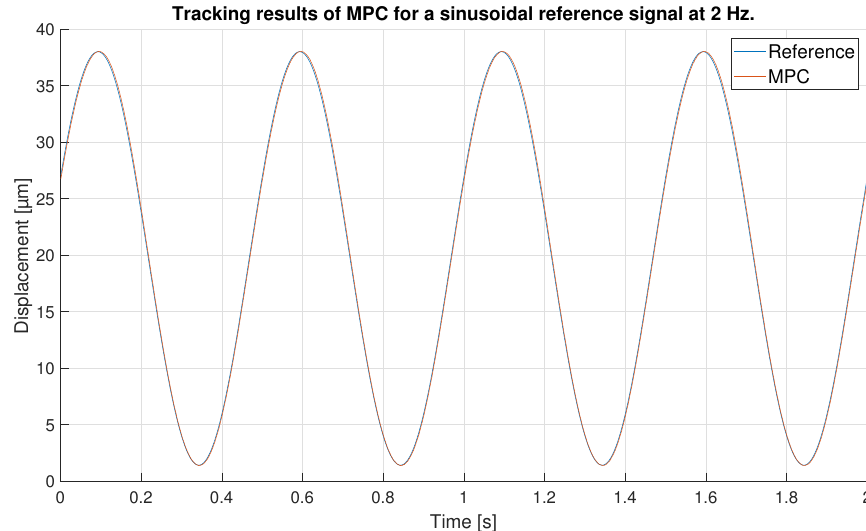
Figure 24. Tracking results of the MPC for a 2 Hz sinusoidal reference of full amplitude.